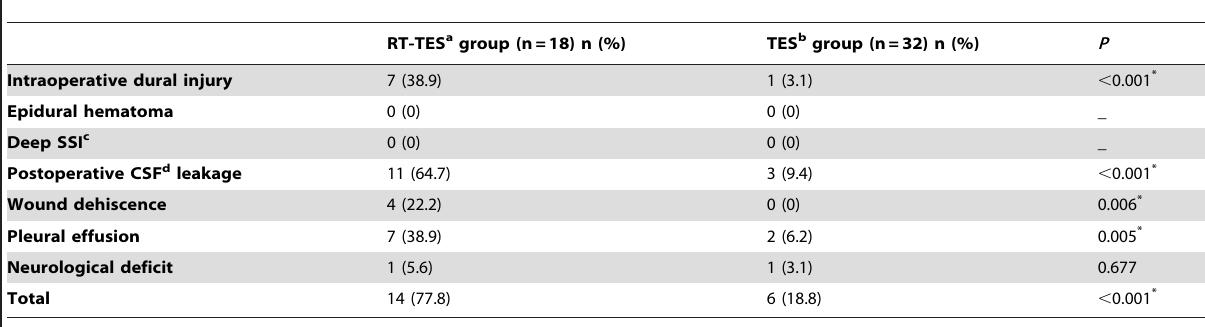
Table 2. Perioperative